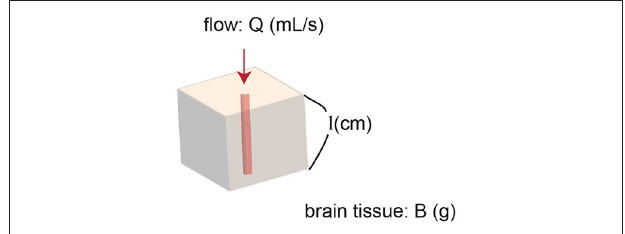
FIGURE 1 | Model of a region of brain. The region contains one vessel. The vessel supplies blood flow to the entire region.